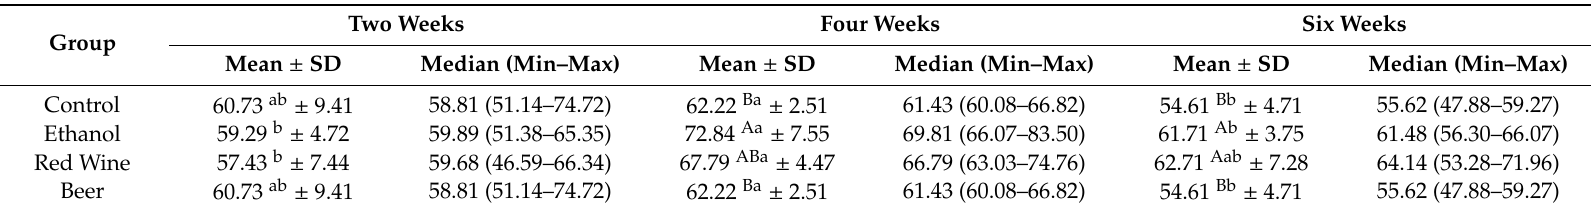
Table 5. Daily total energy supply (kcal / day) in the groups of experimental rats stratified by a group and experiment duration.